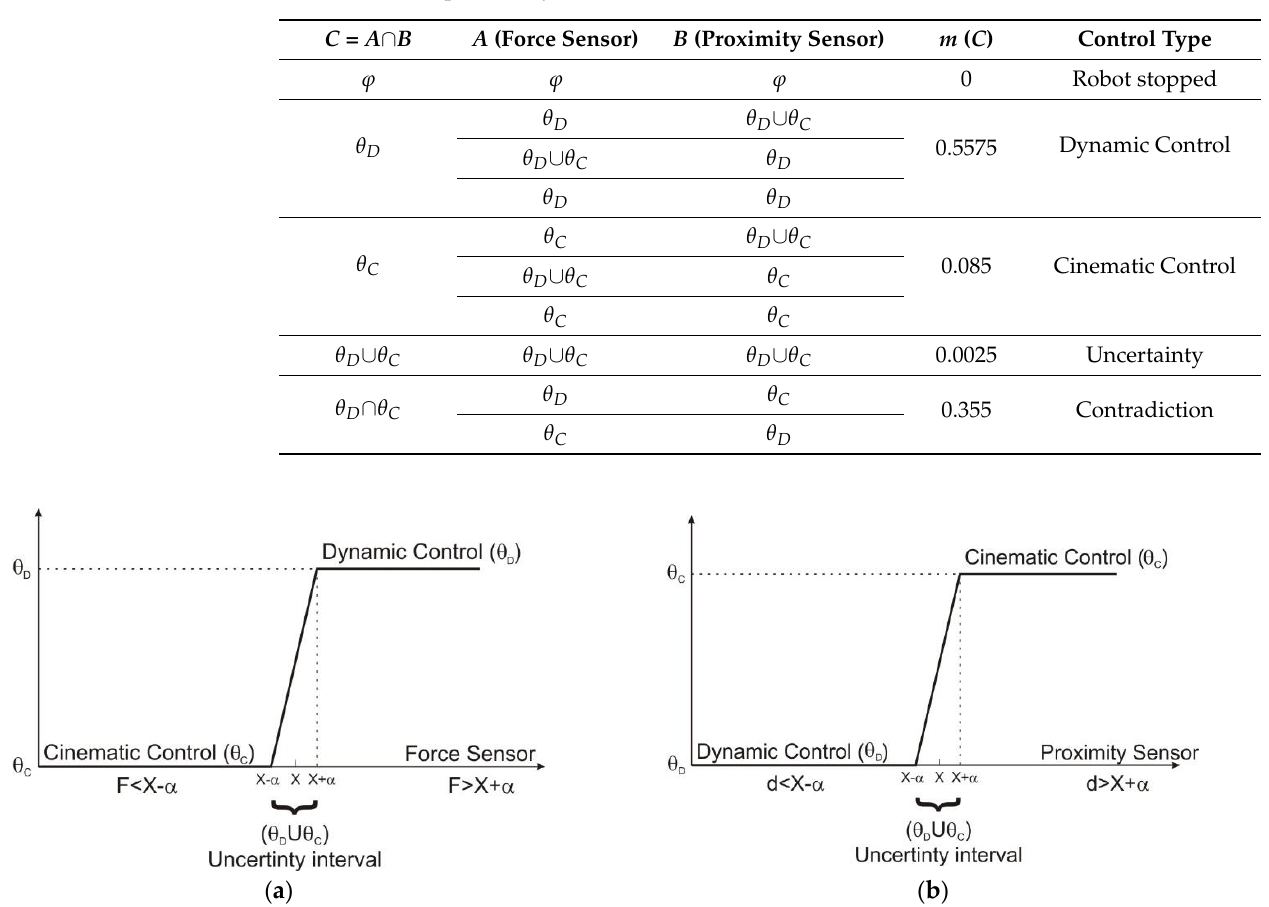
Table 4. Control probability.